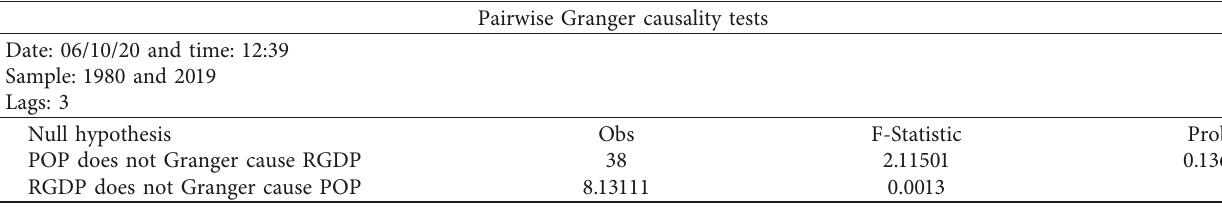
Table 7: Results of the Granger causality test.